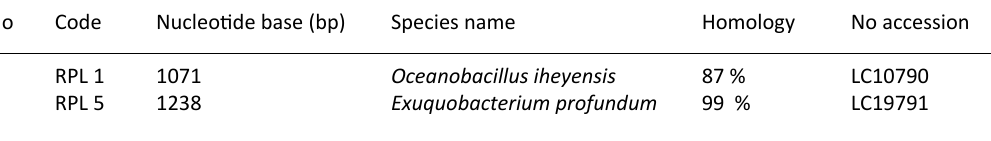
Fig. 1. The Results from the Gel Electrophoresis process - 16S-rRNA Amplification. (M) Marker; (1) Bacteria Identification Code = RPL1 and (2) Bacteria Identification Code = Table 1. Sequencing results (primary forward and reverse)